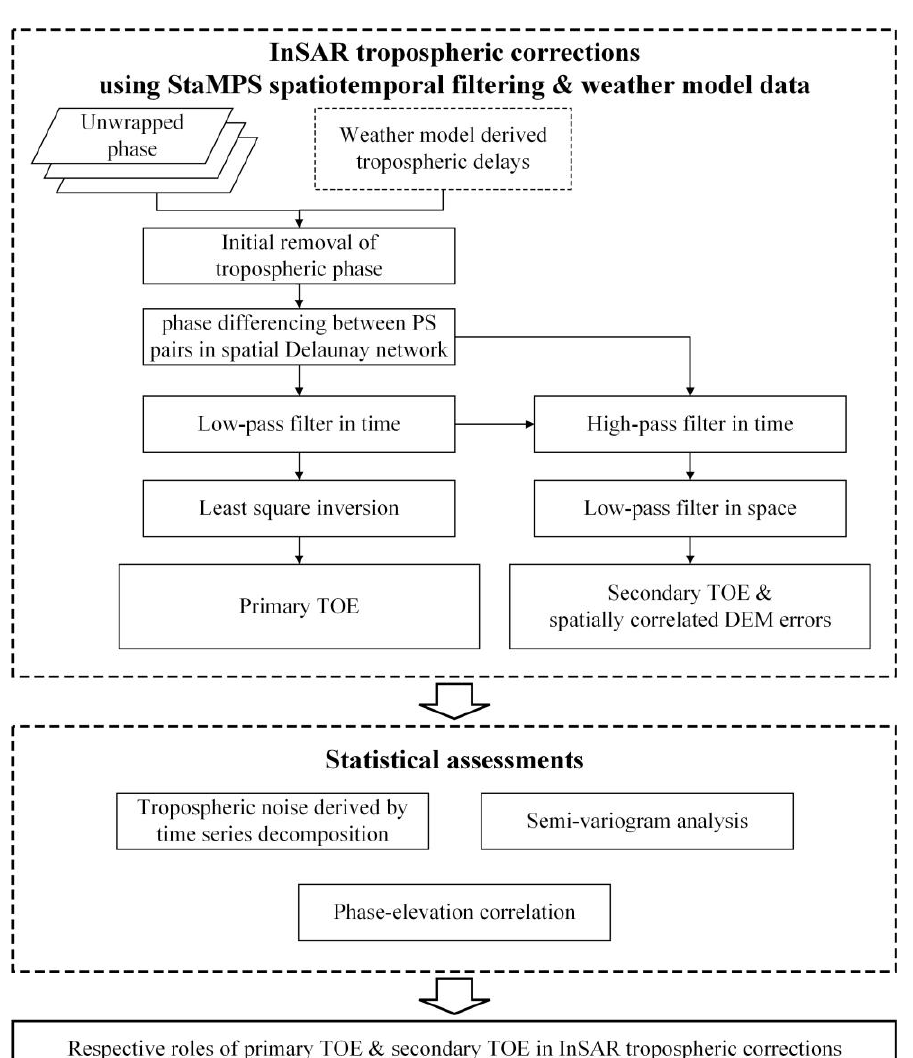
Figure 2. Analysis of the different roles taken by primary and secondary tropospheric and orbit error (TOE) on InSAR tropospheric corrections.